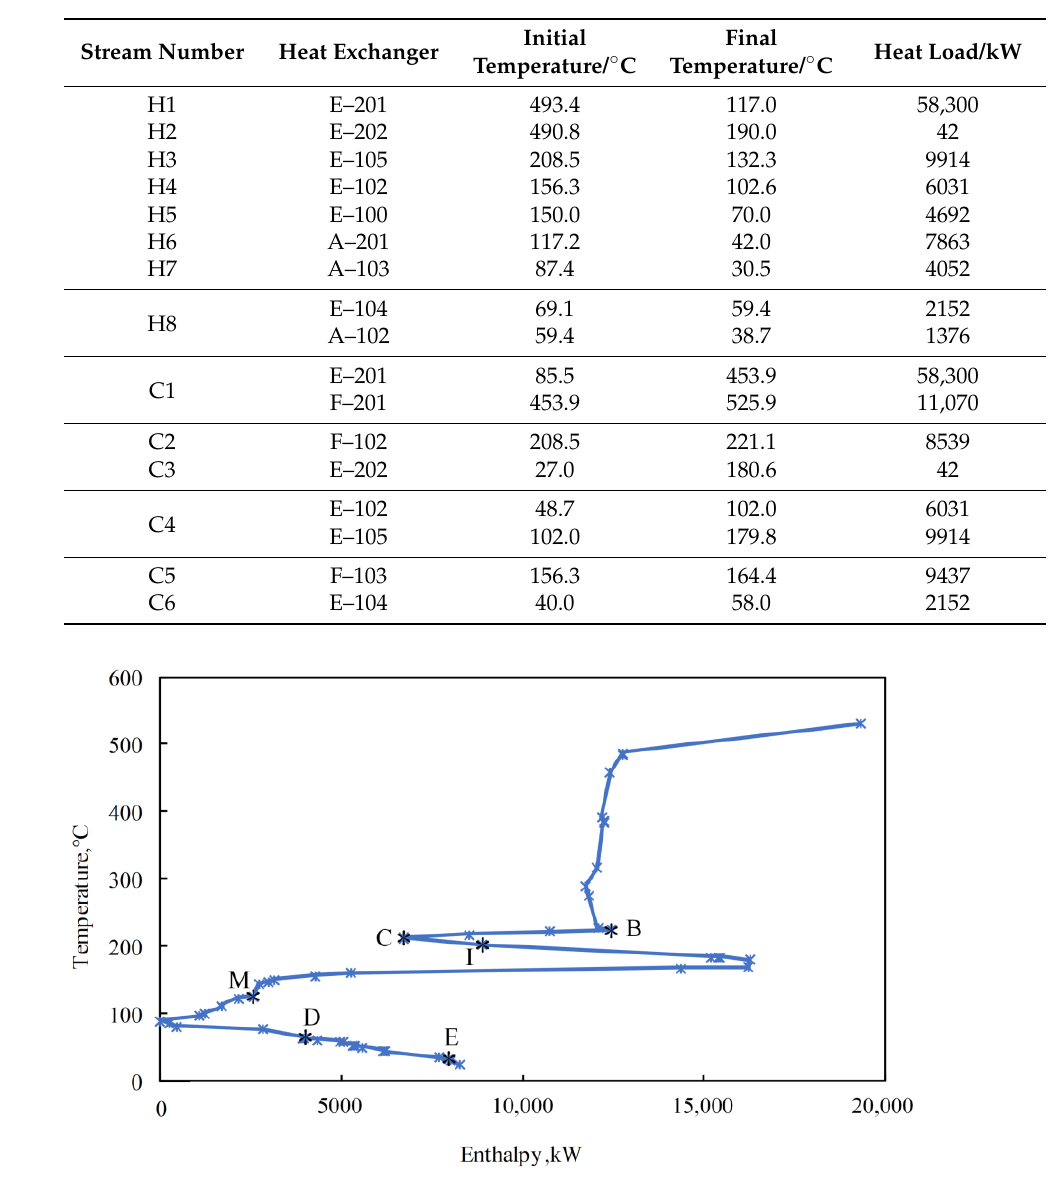
Figure 7. GCC of the heat exchanger